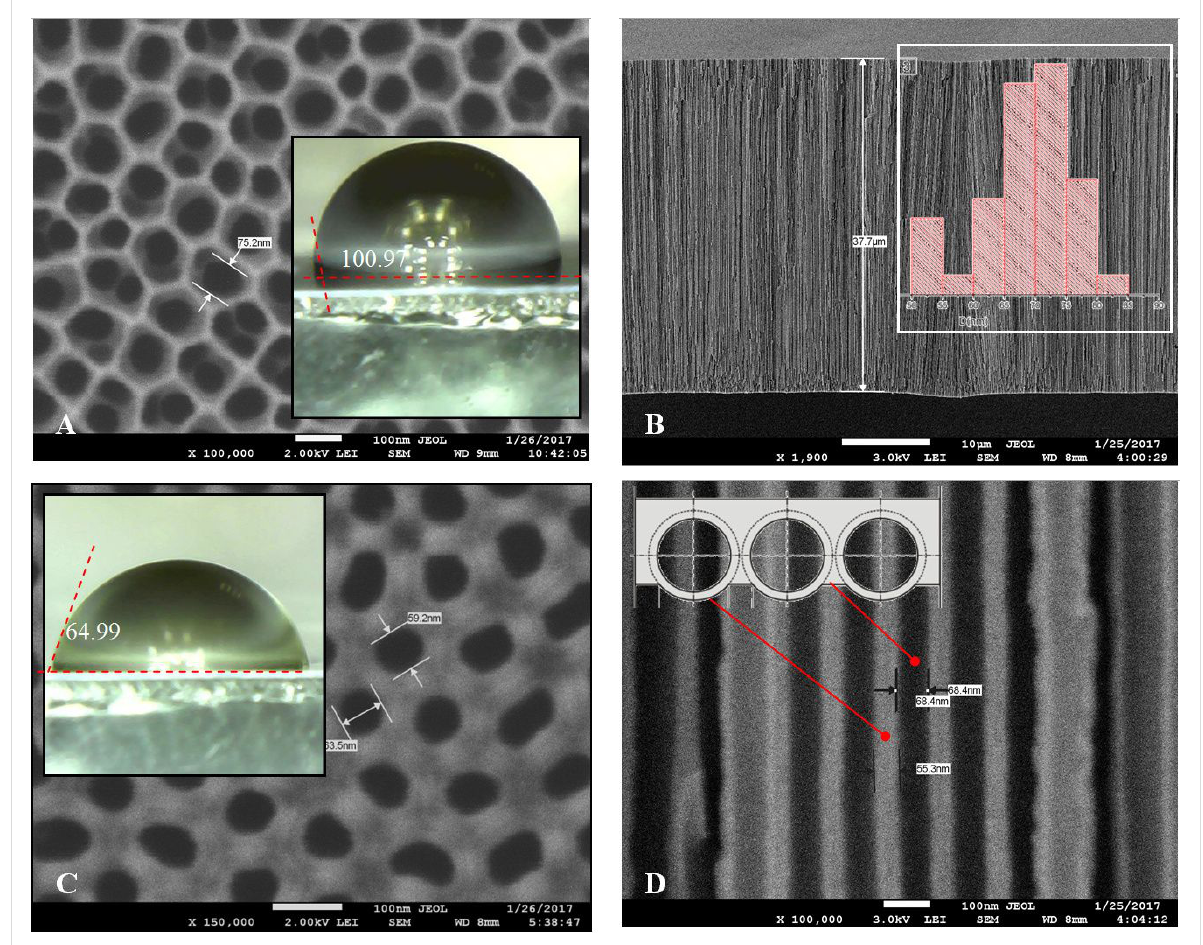
Figure 2: SEM surfaces (A, C) and cross-sectional (B, D) views of sample 2 (type I). In the insets – the contact angle images for the outer (A) and back (C) sides; (B) pore size distribution histogram; (D) the split surface formation scheme